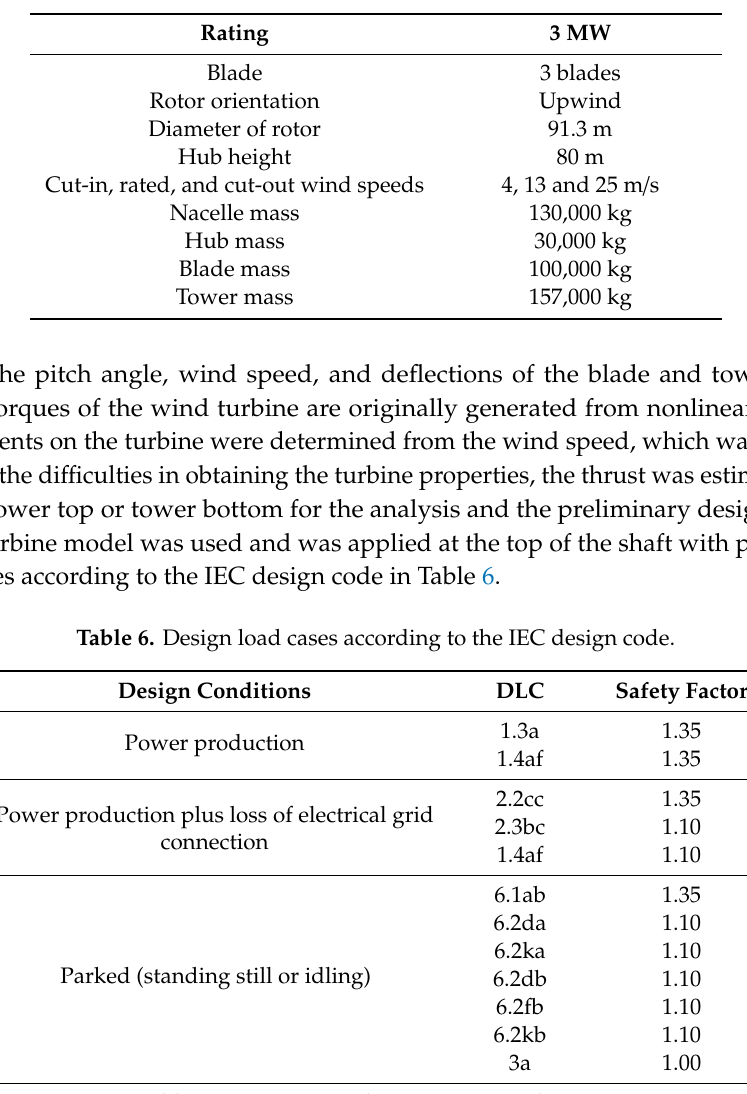
Table 5. Specifications of the WinDS3000 turbine.